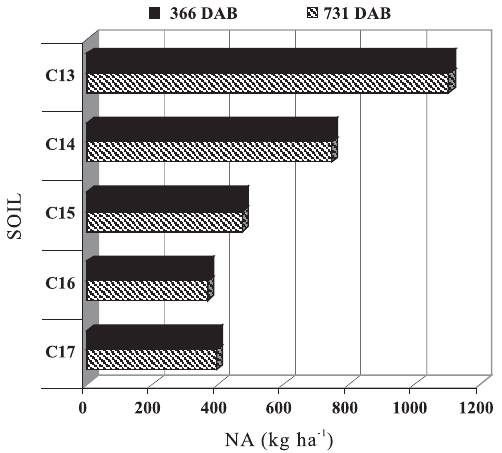
Figure 6. Average soil total-N (NA) distribution at the end of each agricultural year. C to C are 13 17 compartments within soil profile, and DAB = days after beginning. Table 2. Fate of fertilizer N regarding the quantity of N derived from fertilizer (QNdff) and fertilizer N recovery (R) for the different compartments of the soil-coffee-atmosphere system after one (366 DAB) and two (731 DAB) years of cultivation. DAB = Days After